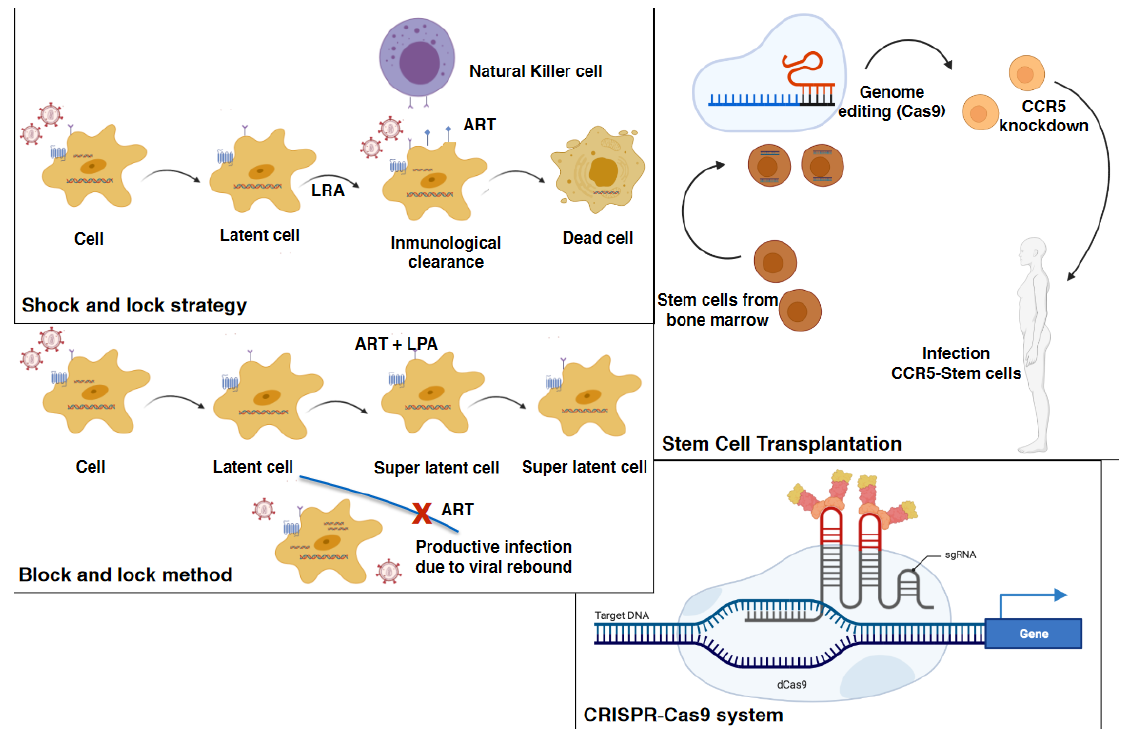
Figure 4. Innovative strategies against HAND. In the “Shock and Kill” approach, integrated pro-viral DNA is kicked into transcriptional activity by an LRA. The virally active cells will subsequently be eliminated with the continuation of antiretroviral therapy during the ‘kill’ phase. Several molecules, including epigenetic modifying agents such as HDACi, HMTi, and DNMTi, have been shown to reactivate the virus in vitro, ex vivo, and in vivo. The ‘Block and Lock’ strategy toward a functional cure aims to permanently silence the latent reservoir by utilizing latency-promoting agents (LPAs) to ‘block’ virus transcription and ‘lock’ virus promoters in a latent state via repressive epigenetic modifications. Stem cell transplantation involves a homozygous CCR5 delta32 stem-cell transplant into an HIV-1 infected patient with acute myeloid leukemia with the removal of antiretroviral treatment without subsequent viremic rebound. In the CRISPRCas9 system, dCas9-SAM minimally affects localized HIV-negative cells in latently infected microglial cells, promonocytes, and T cell lines. A Cas9/guide RNA system has been developed to eradicate the HIV-1 genome and immunize target cells against HIV-1 reactivation.